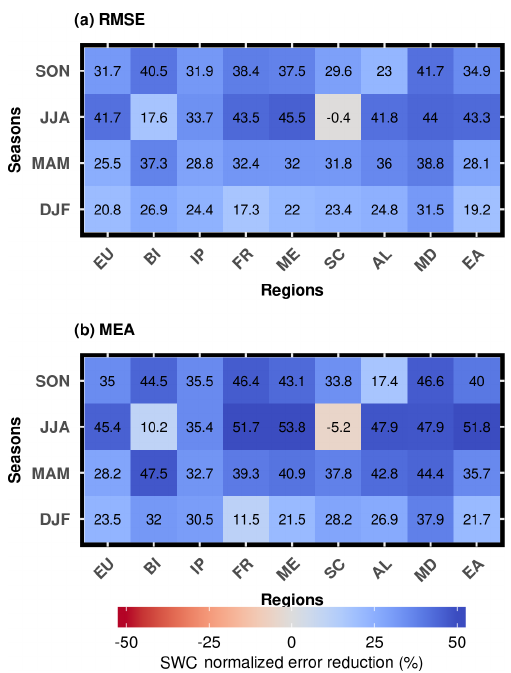
Figure 5. Normalized error reduction (NER) index of (a) RMSE and (b) MEA for daily soil water content over different seasons and PRUDENCE regions using CLM-OL and CLM-DA simula- tions over the years